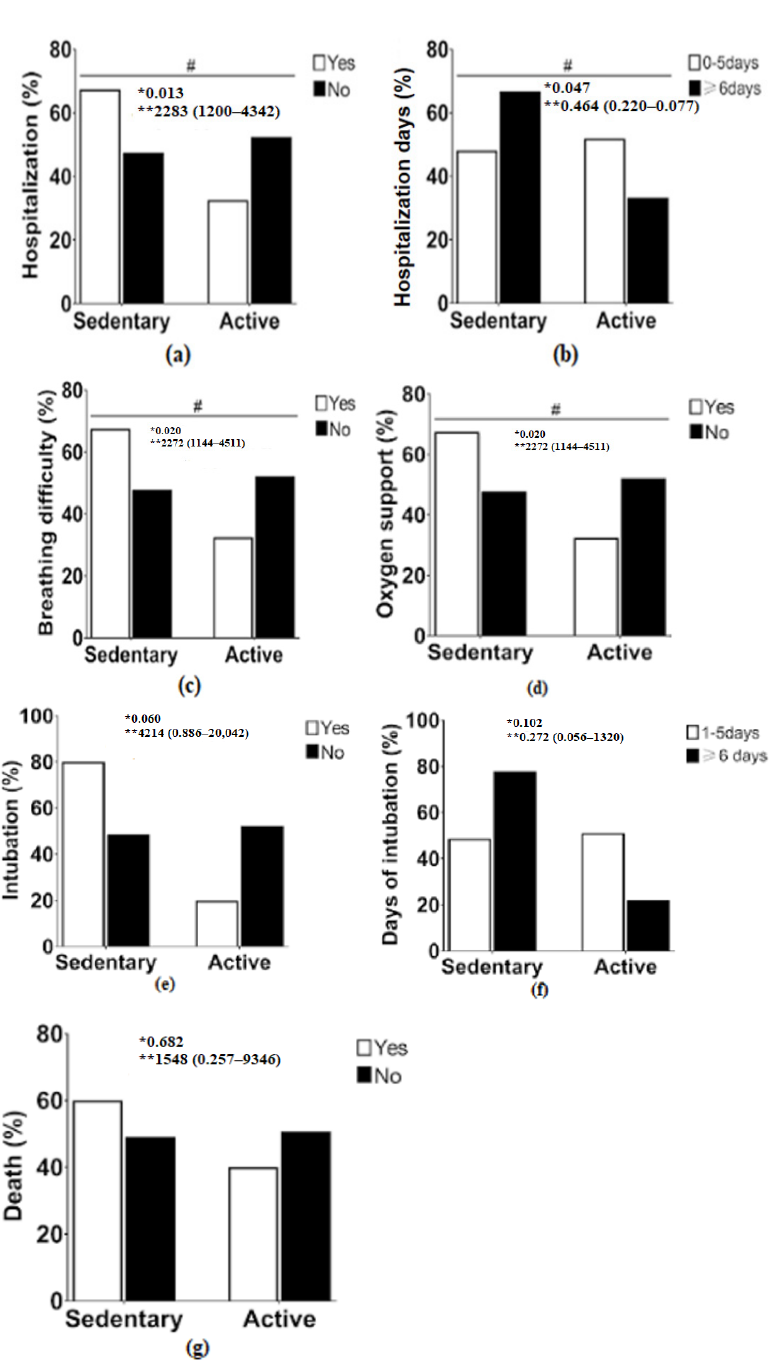
Figure 3. Association between sedentary and active groups and clinical outcomes of COVID-19; ( a ) hospitalization; ( b ) hospitalization days; ( c ) breathing difficulty; ( d ) oxygen support; ( e ) intubation; ( f ) intubation days; ( g ) death. * p value; ** OR (IC 95%); #: significant difference between sedentary and